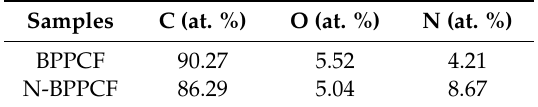
Table 3. Atomic ratio of various N species from deconvolution N 1s spectra.